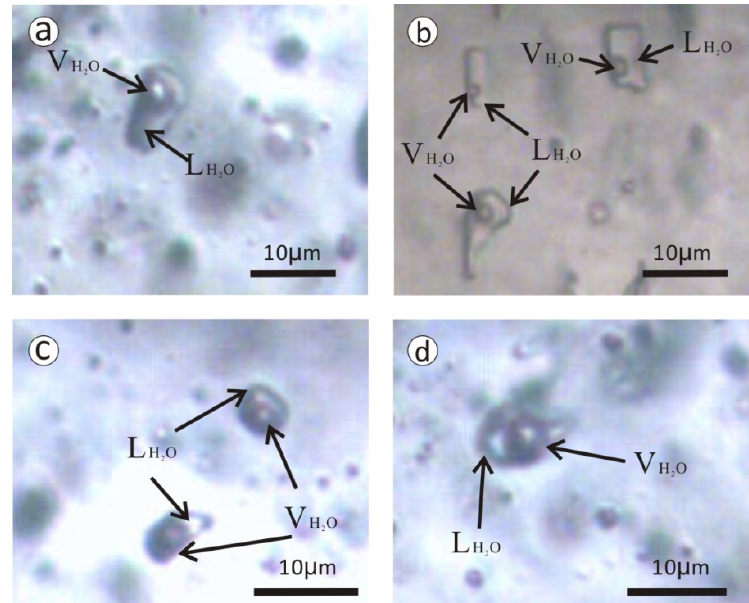
Figure 6. Photomicrographs of fluid inclusions types from the Xialiugou deposit. The two-phase liquid-rich fluid inclusions (I a ) were near ellipsoidal ( a ), and irregular ( b ); the two-phase vapor-rich fluid inclusions (I b ) were near ellipsoidal ( c ), and irregular ( d ). L H2O liquid H 2 O, V H2O vapor H 2 O.